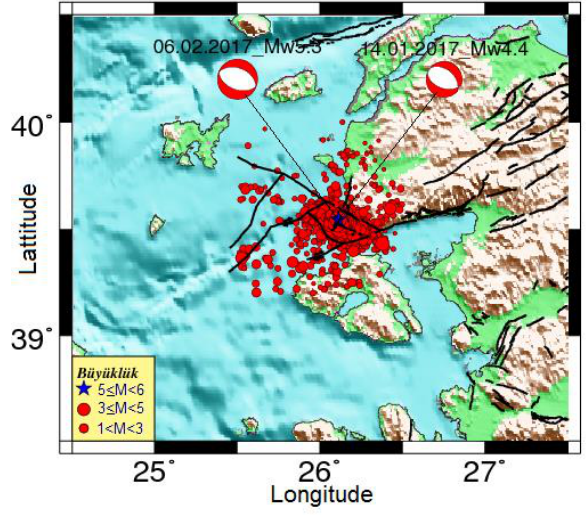
Figure 2. The focus mechanism solutions of earthquakes and epicenter in earthquakes between January 1, 2017 and August 31, 2018 in Canakkale Ayvacik.